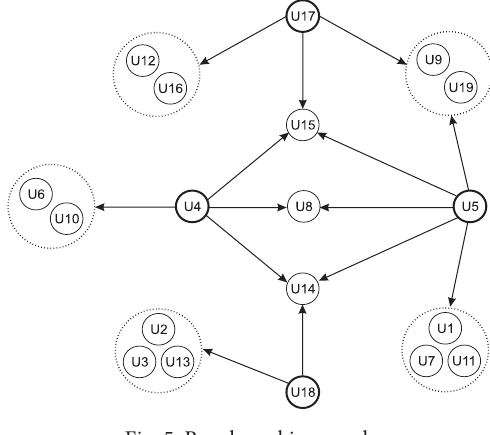
Fig. 5. Benchmarking graph Source: Calculated by the